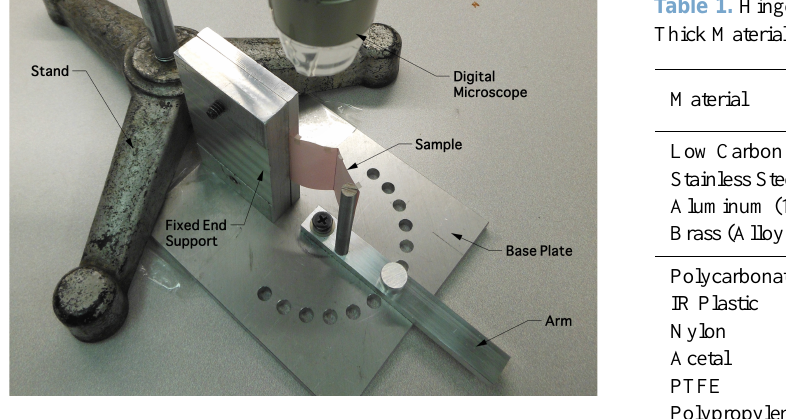
Figure 6. The test fixture with sample deflected to positive 90 de- grees. Data is collected from the image captured by the Dino-Lite ™ digital microscope which views the fixture from